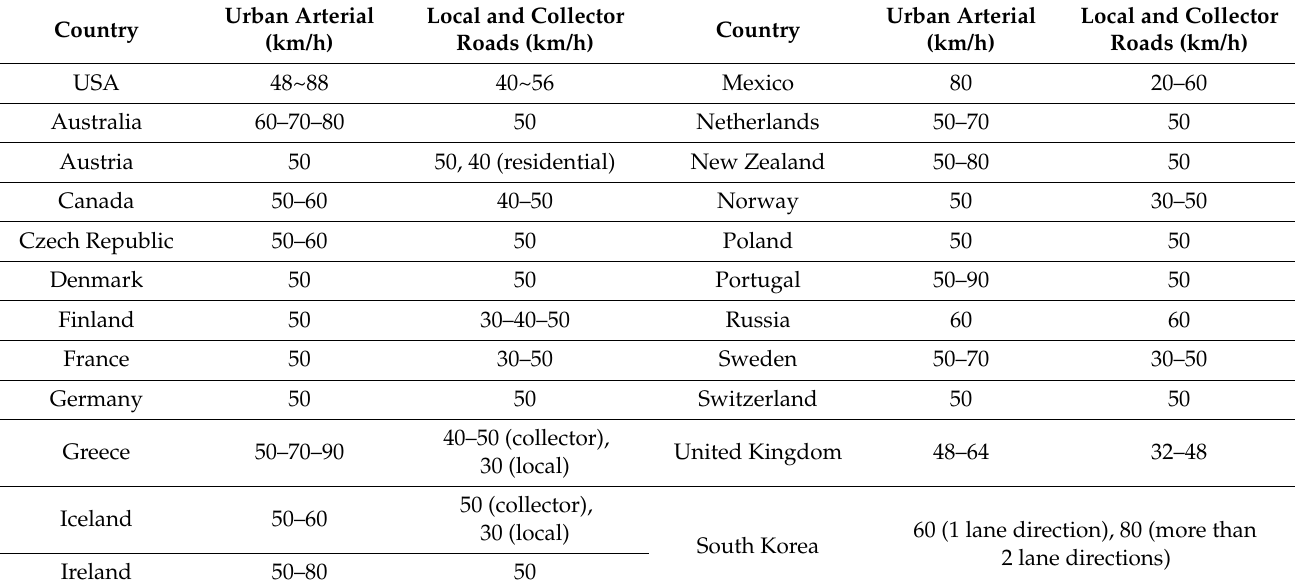
Table 2. General speed limits in OECD